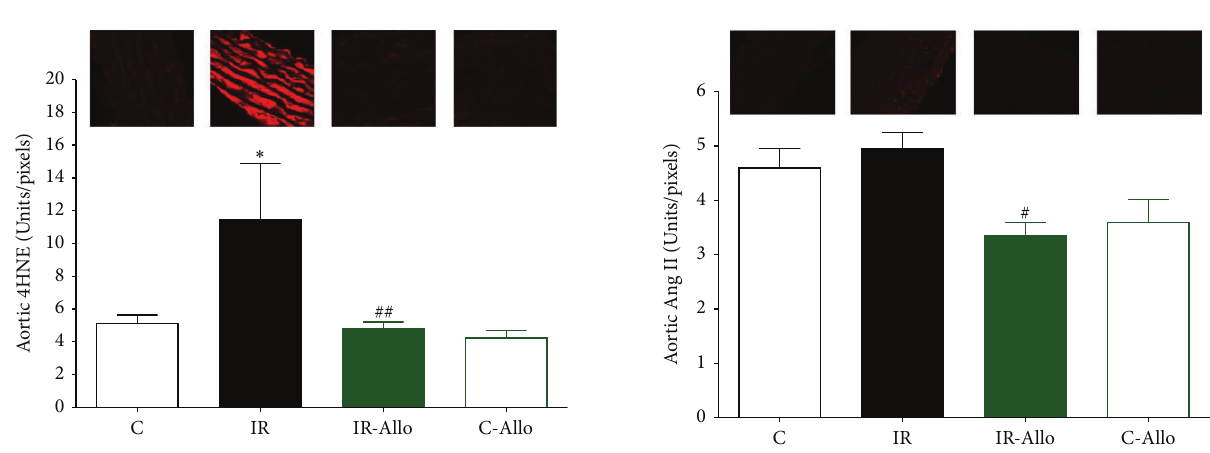
Figure 6: The effect of allopurinol (Allo) treatment on insulin resistance (IR) induced Ang II changes, measured in Units/pixels. Values are expressed as the mean ± SEM; 𝑁 = 6 – 8 animals; ∗ 𝑃 < 0.05 , compared with the corresponding control group values; # 𝑃 < 0.05 compared with thecorresponding IRgroup values, by One-Way ANOVA and Newman-Keuls post hoc